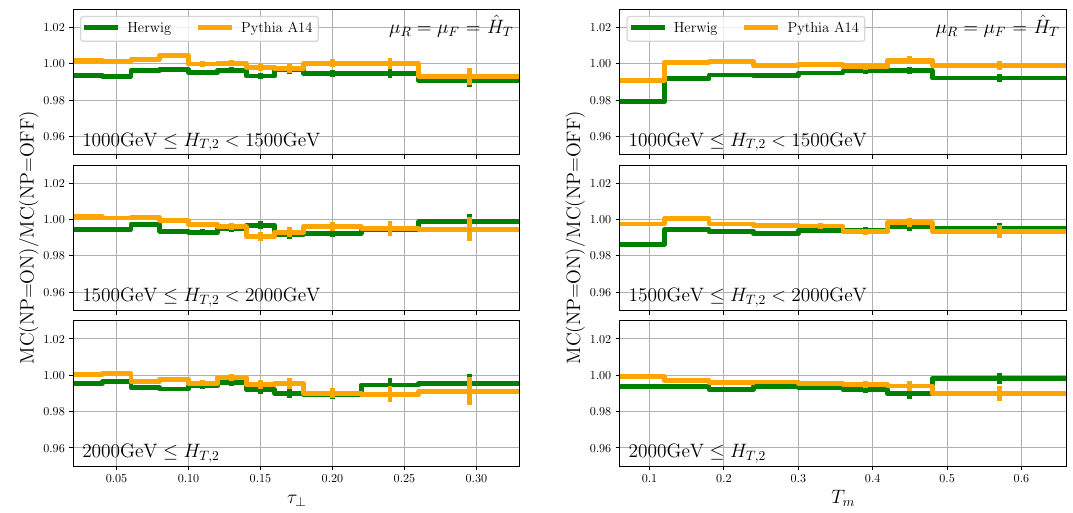
Figure 9 . The transverse thrust τ ⊥ (left) and the thrust minor T m (right) in three H T, 2 bins. The solid lines show the estimated non-perturbative effects from Herwig and Pythia